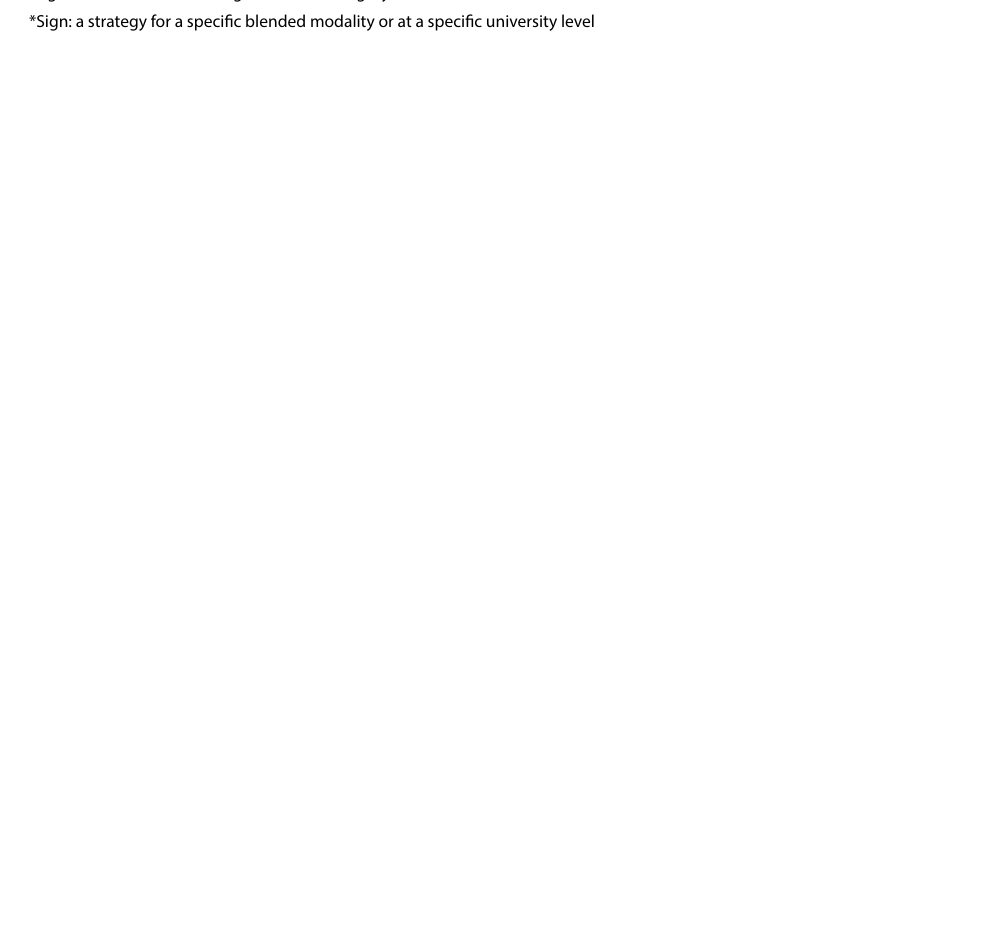
Boldface: meta-categories and categories of teachers’ strategies Regular text: teachers’ strategies inside a